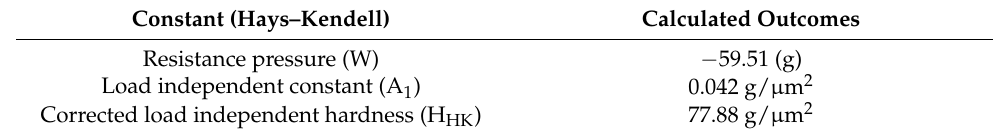
Table 7. Calculated HK constant W, A 1 and H HK for UGA.